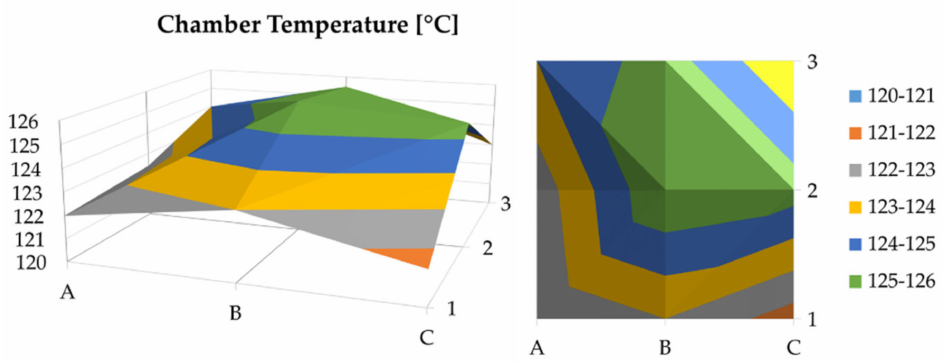
Figure 3. Temperature distribution inside the chamber with temperature set at 125 ◦